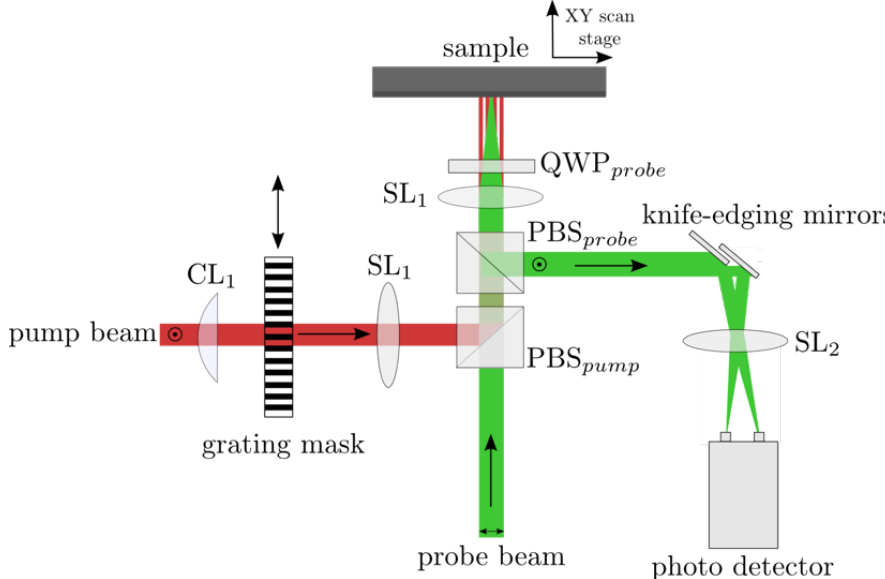
Figure 3. Schematics of the GILBD setup. In this setup, grating excitation, explained in Figure 4